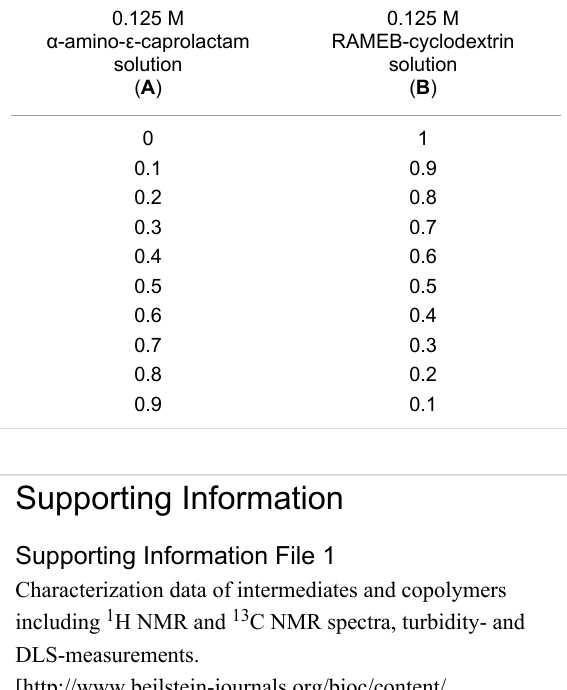
Table 2: Different amounts of standard solution ( A ) and ( B